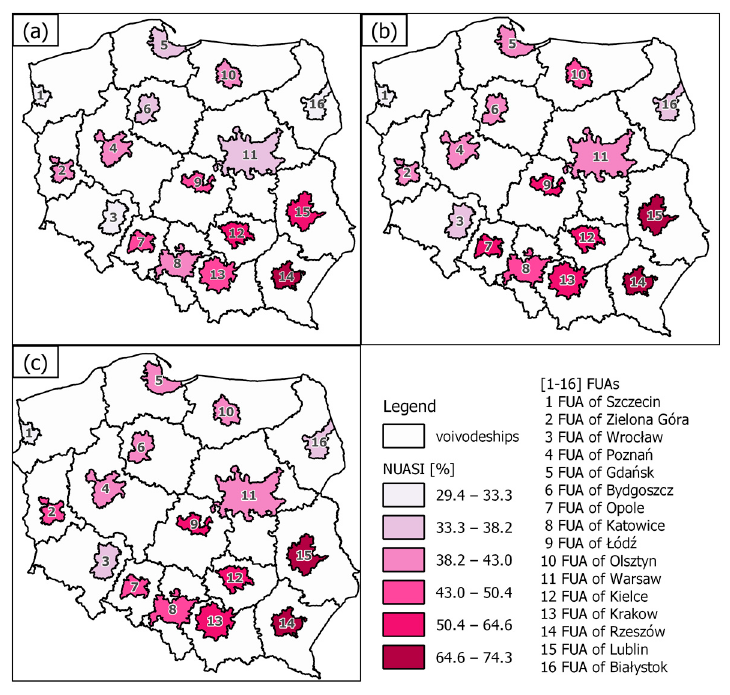
Figure 2. The NUASI in 2006 ( a ), 2012 ( b ), and 2018 ( c ).